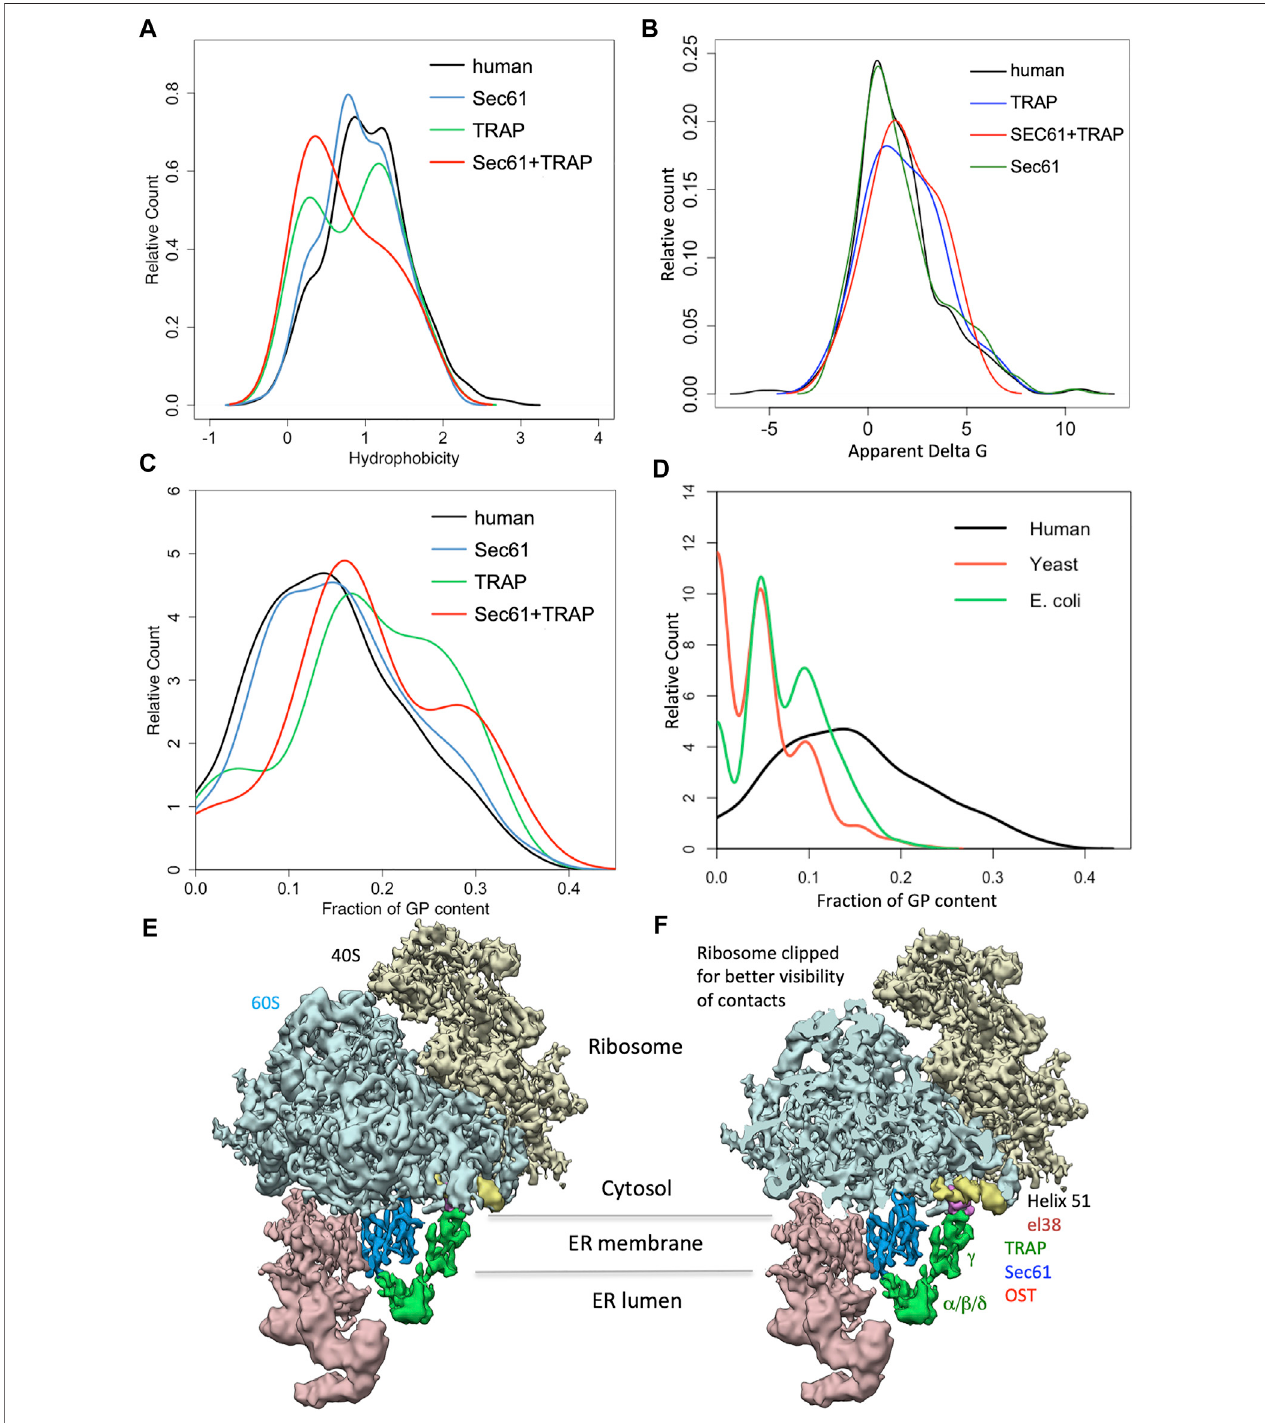
FIGURE 11 | Physicochemical properties of SPs of TRAP clients. (A – C) We used custom scripts to compute the hydrophobicity score (A) , apparent delta G (B) , and glycine/proline (GP) content (C) of SP sequences. Hydrophobicity score was calculated as the averaged hydrophobicity of its amino acids according to the well- known Kyte-Doolittle propensity scale. Apparent delta G values were determined with the Δ G app predictor for TM helix insertion (http://dgpred.cbr.su.se). GP content was calculated as the total fraction of glycine and proline in the respective sequence. (D) We also used custom scripts to extract protein annotations for all human, E.coli and S.cerevisiae SPsfromUniProtKBentriesandtocalculatetheirGPcontent. (E,F) Cartoonofunclipped (E) andclipped (F) 80SribosometogetherwithSec61- complex and TRAP, and OST. Notably, without clipping eL38 and helix 51 is partially hidden.